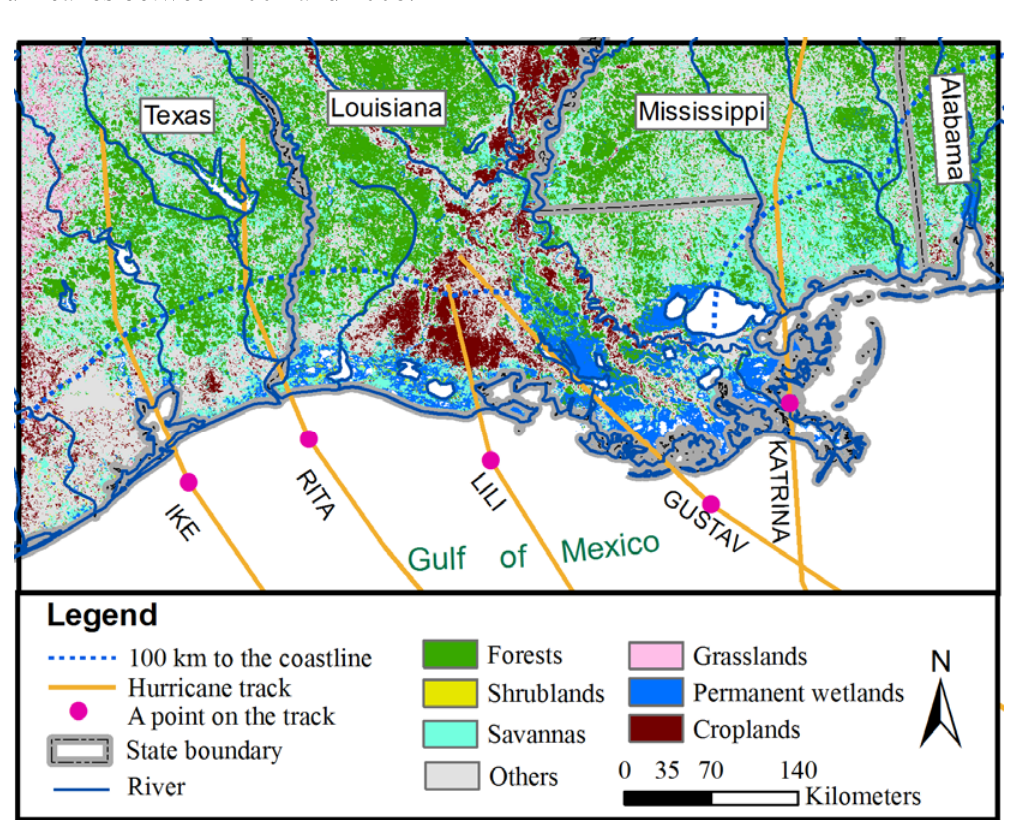
Figure 1. Distribution of main vegetation groups in northern Gulf of Mexico and landfalls of hurricanes between 2002 and